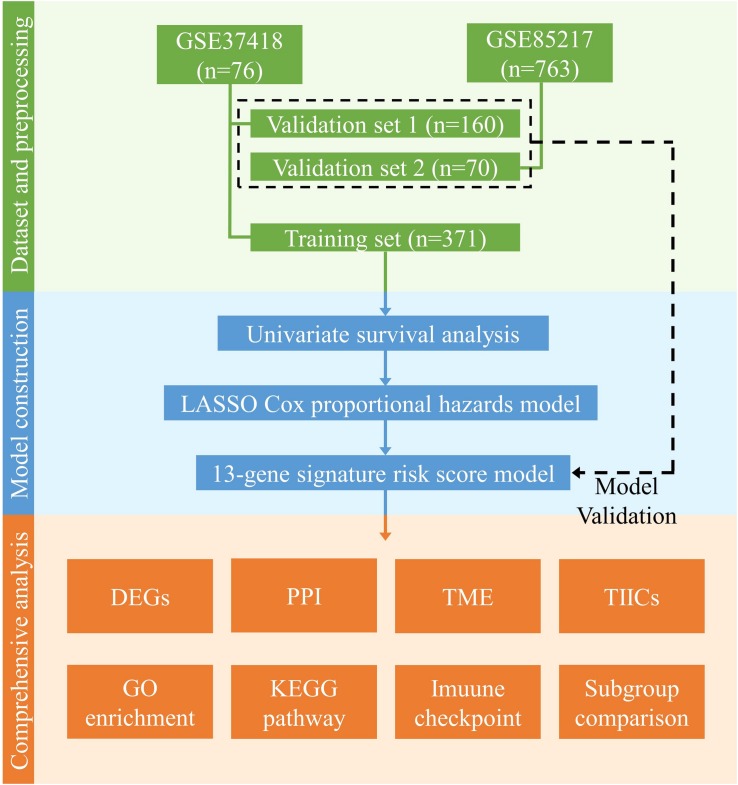
Design and workflow of this study. Public medulloblastoma datasets, including 763 (GSE85217) and 76 cases (GSE37418), were included in our analysis. Cases in GSE85217 were divided into the training set (n = 371) and validation set 1 (n = 160), and cases in GSE37418 were assigned as validation set 2 (n = 70) for cross-platform and external validation. We constructed our gene-signature-based risk score model using a training set and validated with two validation sets. Using the constructed model, we then performed comprehensive analysis, including analysis of DEGs, PPI network, TME, TIICs, immune checkpoint, KEGG pathways, and GO enrichment, as well as a comparison of established medulloblastoma molecular and histological subgroups.